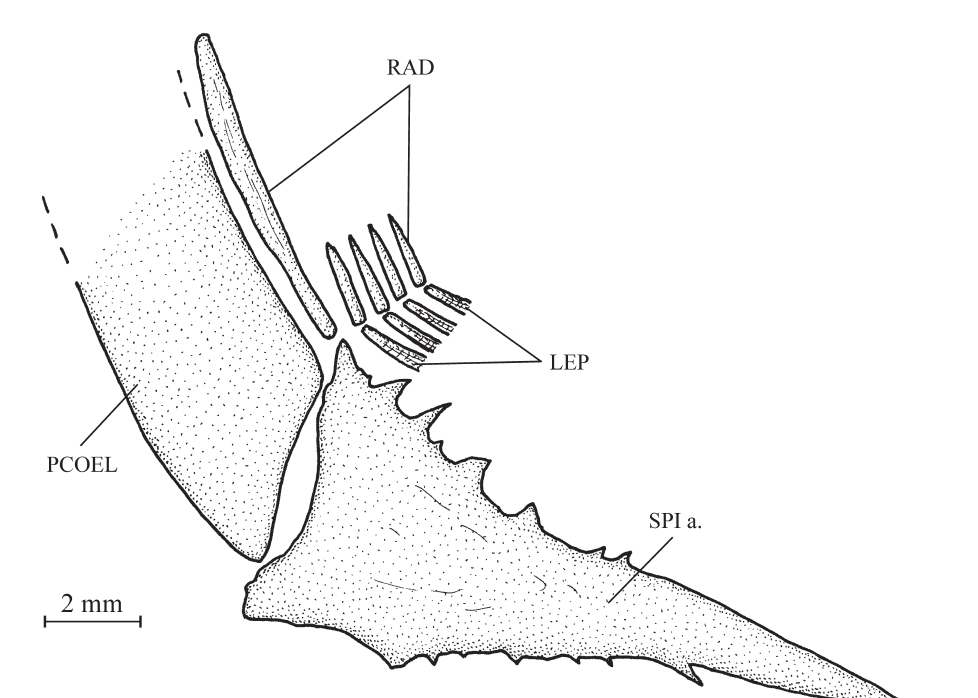
Fig. 20. Rostropycnodus gayeti gen. et sp. nov. The pelvic and anal region of holotype CLC S-608 (above) and of paratype CLC S-595 (below).